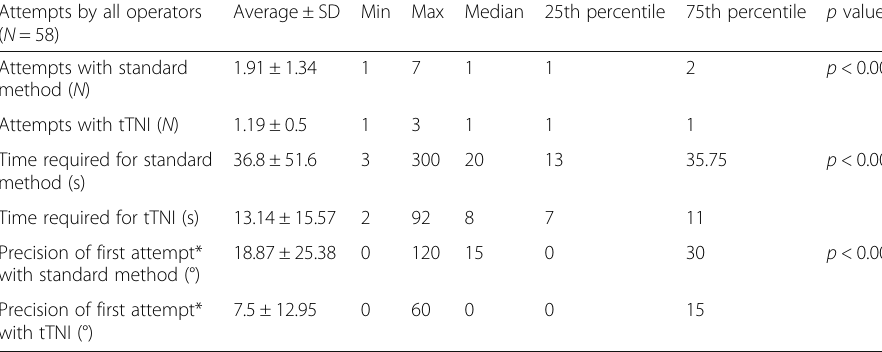
Table 2 Comparison of translaryngeal Tracheostomy Needle Introducer versus standard needle puncture technique among all operators Attempts by all operators ( N =